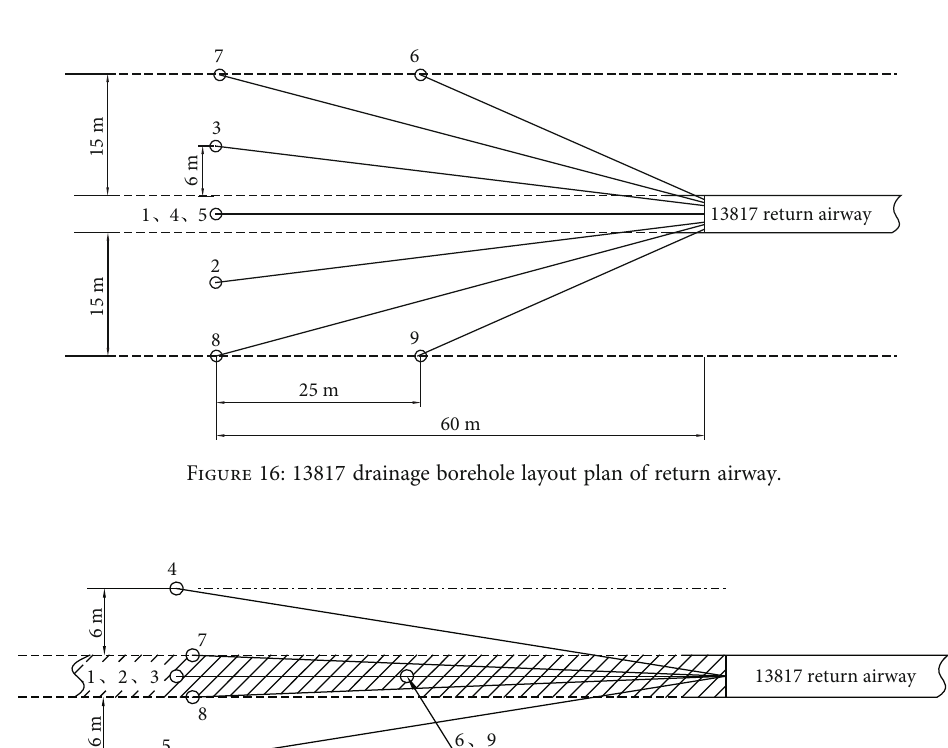
Figure 15: Layout plan of drainage borehole in 13817 heading face.